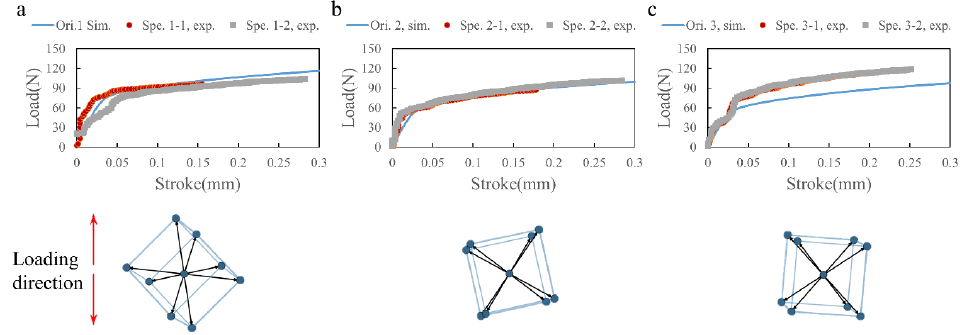
Figure 5. Measured and simulated load stroke curves of ( a ) initial orientation 1; ( b ) orientation 2; and ( c ) orientation 3. Crystal lattices before tensile loading were given with black lines highlighting <111> slipping directions. Loading direction was given with red